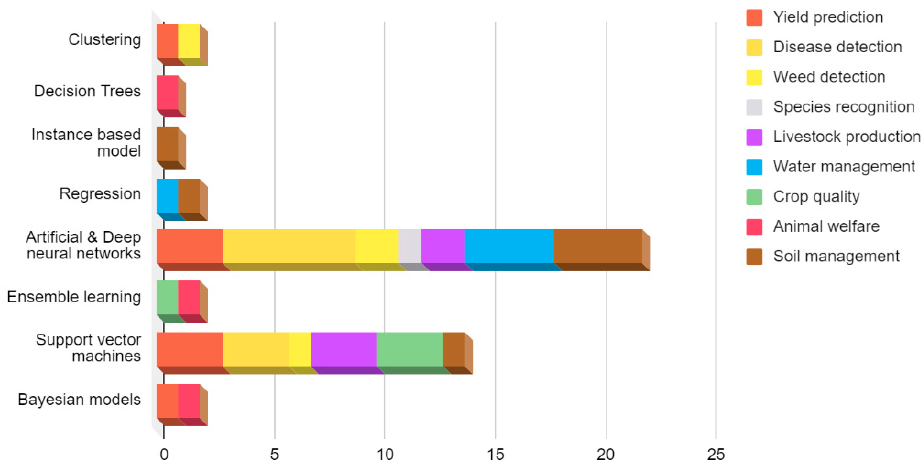
Figure 3. ML techniques used in agriculture [9].